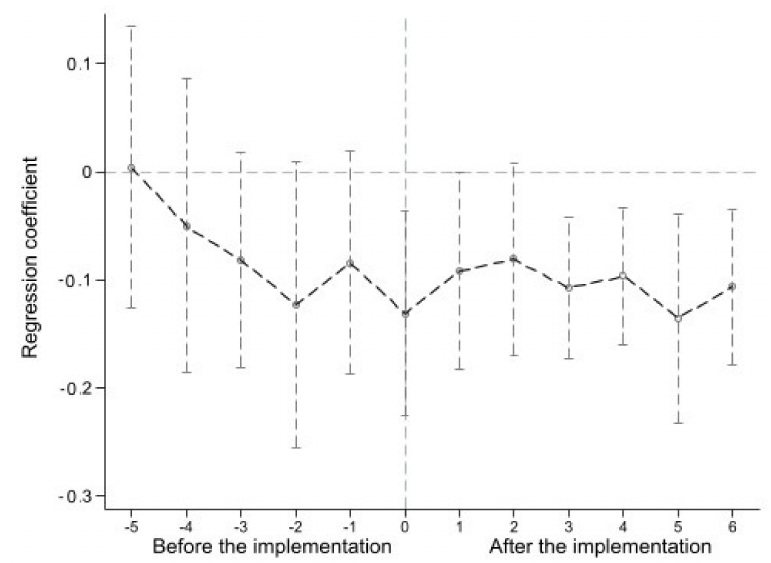
Figure 5. Dynamic impact of the high-standard farmland construction policy on rural poverty.